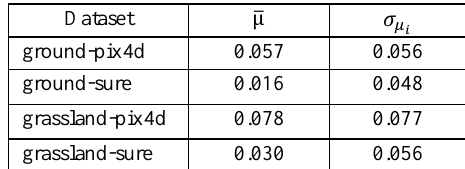
Table 2. Accuracy measures of DIM point cloud in the whole block. (Unit: